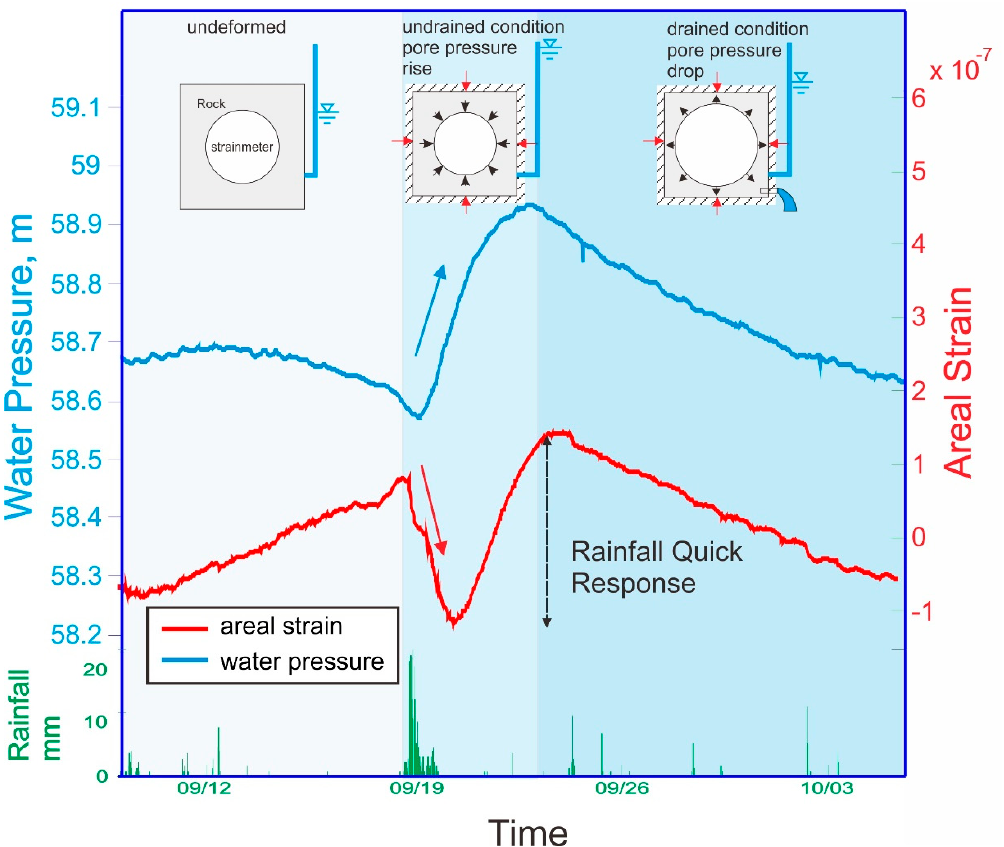
Figure 3. The diagram shows the relation between the strainmeter strain and groundwater pressure induced by rainfall. Data from the DARB station located in Southern Taiwan (location shown in Figure 1).